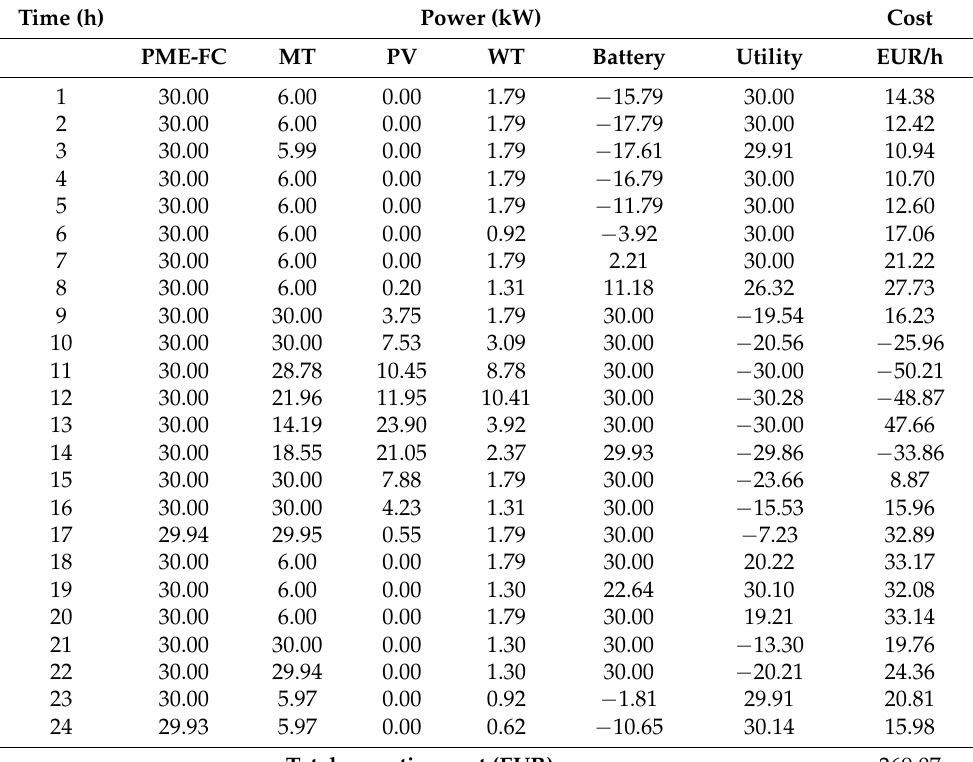
Table 2. The best results obtained using EO for the energy management (EM) problem (Case 1). Time (h) Power